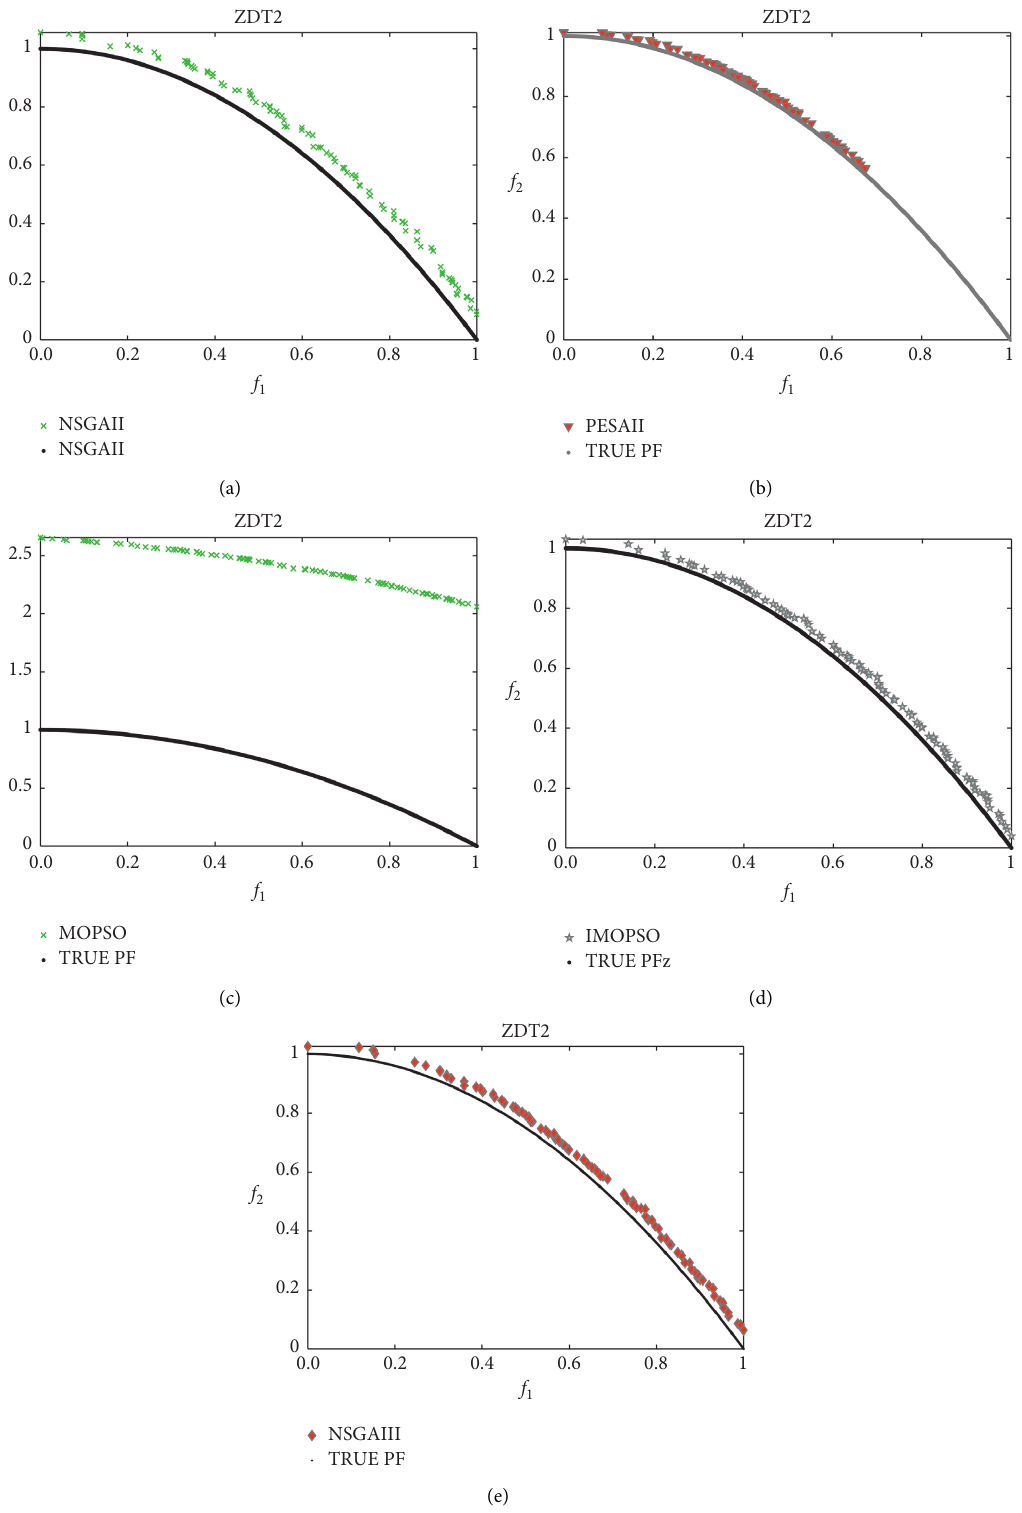
Figure 3: ZDT2 test